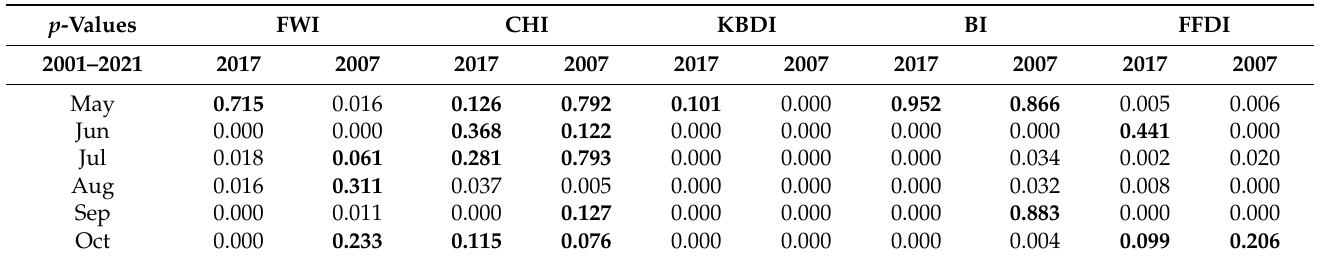
Table 7. Student’s t -test p -values (at a 5% significance level) for the monthly average values between 2001–2021, 2017, and 2007 for FWI, CHI. KBDI, BI, and FFDI mean values, respectively for mainland Portugal (H 0 not rejected in